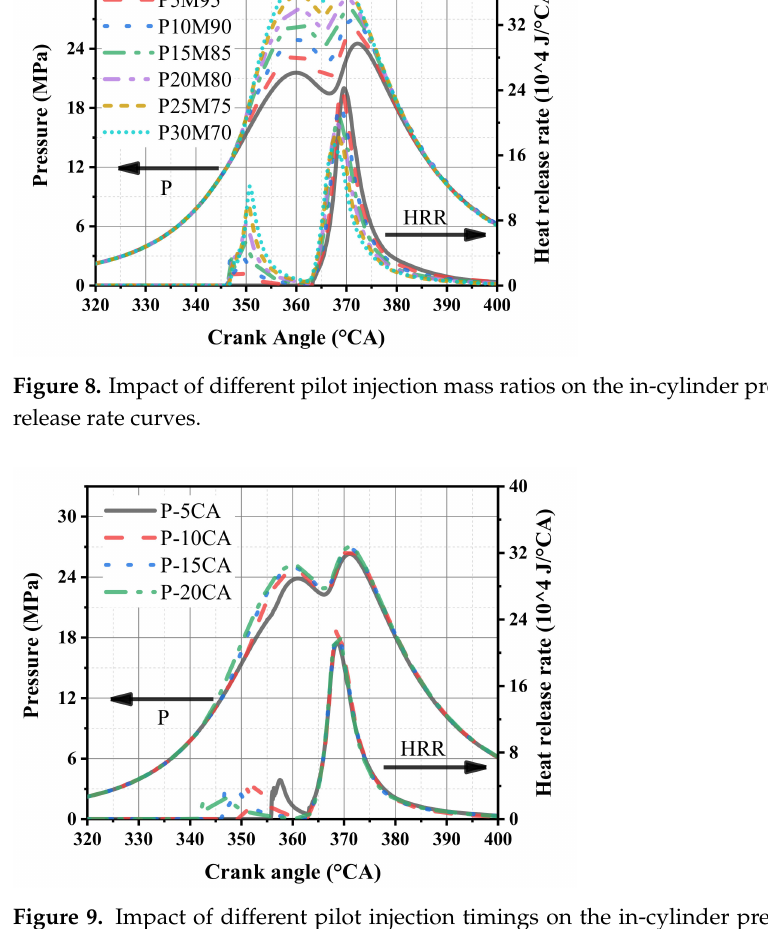
Figure 9. Impact of different pilot injection timings on the in-cylinder pressure curves and heat release rate